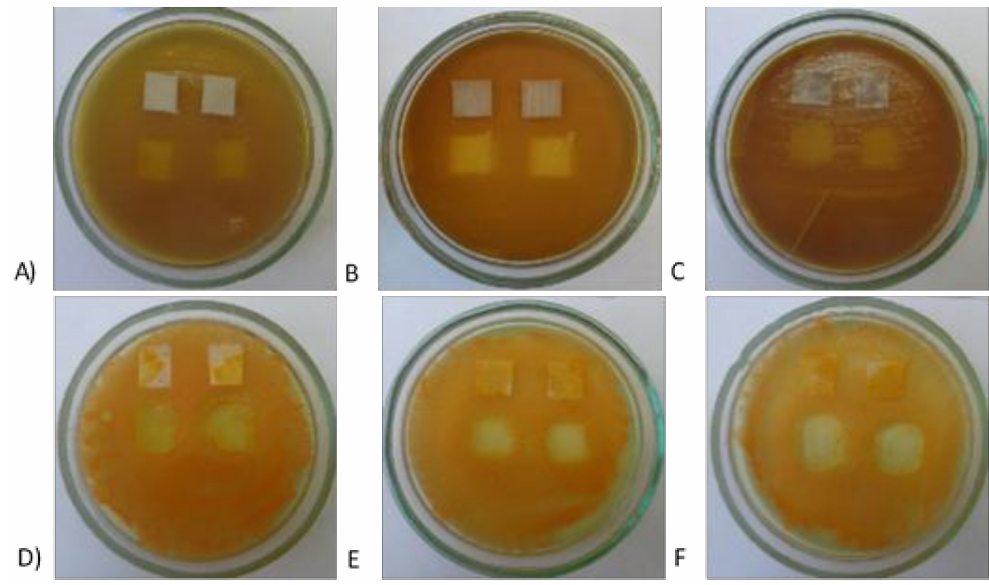
Figure 13. The effect of the modified polymer textiles on the viability of E. coli (PET-ZnO ( A ); PA-ZnO ( B ); and PP-ZnO ( C )) and S. aureus (PET-ZnO ( D ); PA-ZnO ( E ); and PP-ZnO ( F )) determined by the plate